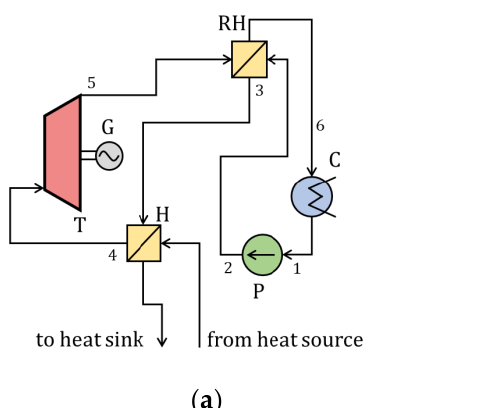
T – turbine; G — generator; RH — regenerative heat exchanger; C — condenser; P — pump. T—turbine; G—generator; RH—regenerative heat exchanger; C—condenser;